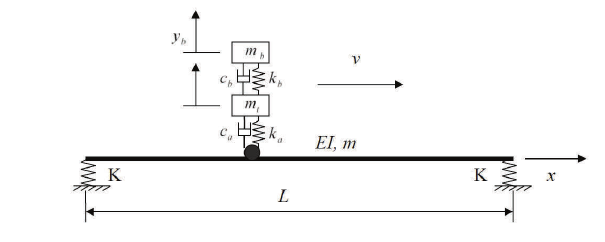
Figure 5. Elastic supported beam subjected with a spring- mass